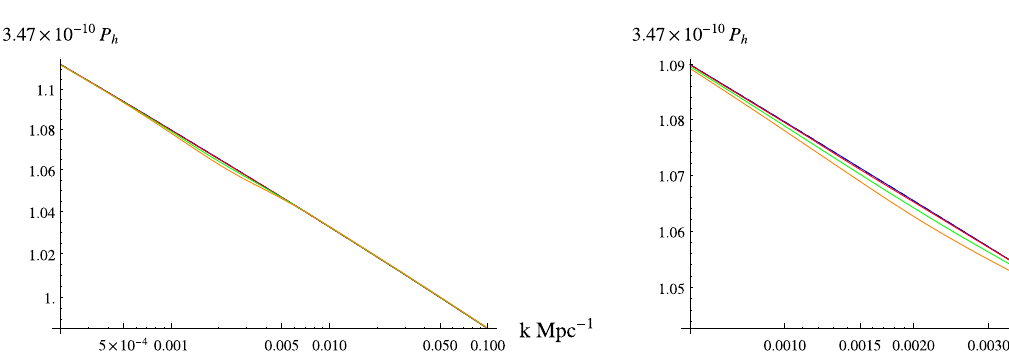
Fig. 3 The power spectrum of primordial tensor perturbations P h is featureless spectrum. The plot on the right corresponds to a zoom of the left plot. As can be seen, the effects of the different features on the plotted for λ = − 4 × 10 − 12 ,σ = 0 . 05, and k 0 = 1 . 2 × 10 − 3 ( blue ), λ = − 10 − 12 ,σ = 0 . 05, and k = 1 . 3 × 10 − 3 ( red ), λ = − 10 − 11 ,σ = spectrum P h are rather small and the spectra of the models with features 0 0 . 04, and k 0 = 1 . 3 × 10 − 3 ( green ), and λ = − 1 . 5 × 10 − 11 ,σ = 0 . 04, are difficult to distinguish from the featureless model and k 0 = 1 . 2 × 10 − 3 ( orange ). The dashed lines correspond to the